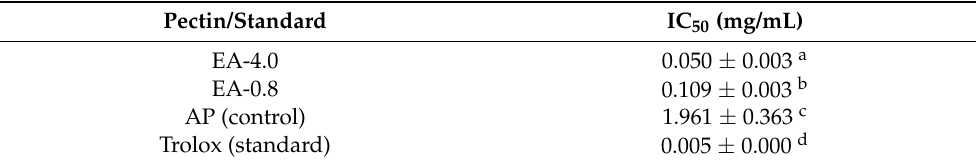
Table 6. The Pearson correlation coefficients between DPPH scavenging activity (in %) with the physicochemical characteristics of pectins and fractions ( n = 32). Second Variable **